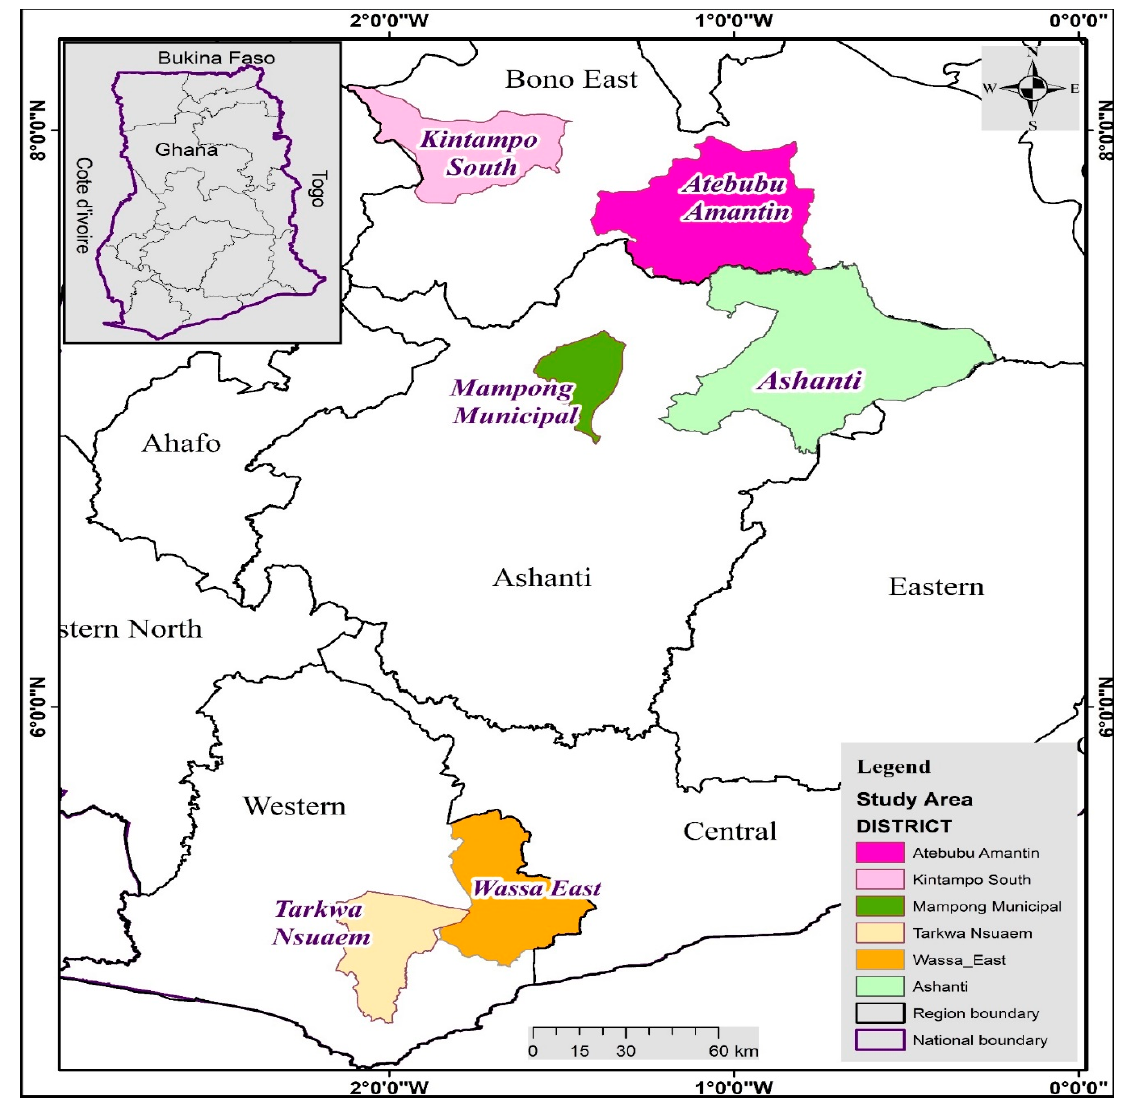
Figure 1. Study Area.